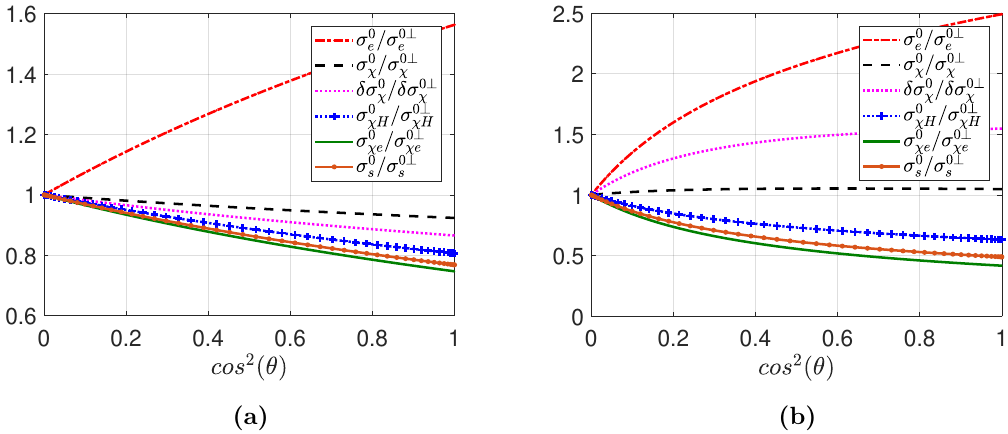
Figure 4. (cid:18) -dependence of the TCs: (a) (cid:20) B = (cid:20) E = 0 : 25 and (b) (cid:20) B = (cid:20) E = 0 :